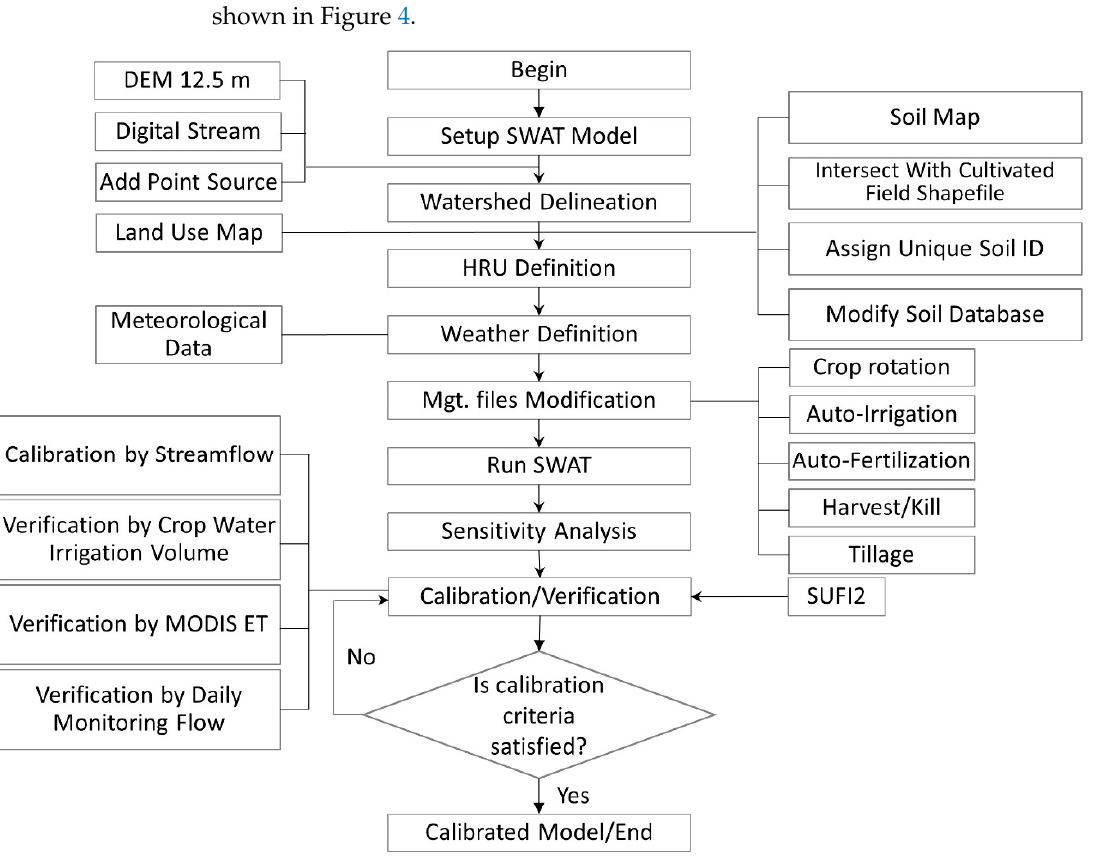
Figure 4. General flowchart followed in the modeling